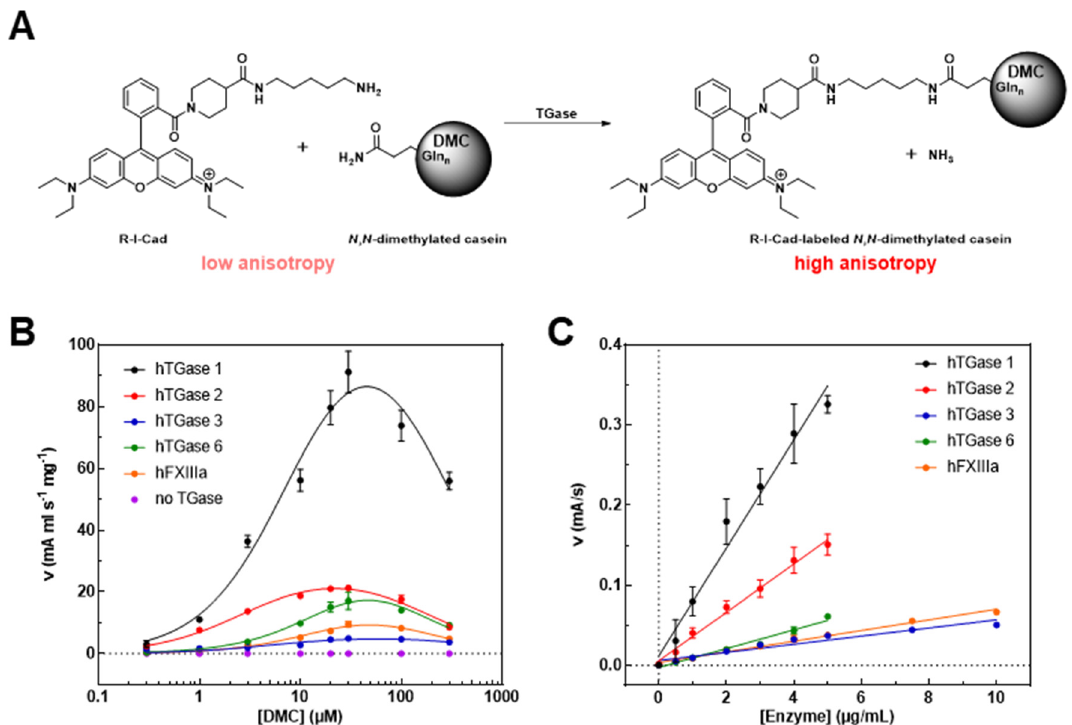
Figure 1. Incorporation of R-I-Cad into DMC by different TGases. ( A ) Principle of the FA-based TGase activity assay. ( B ) Plots of rate versus DMC concentration for the reaction of DMC with R-I-Cad (0.74 µ M) in the absence and presence of different human (h) TGases (2 µ g/mL for hTGase 1; 5 µ g/mL for hTGases 2, 3, 6 and hFXIIIa). Nonlinear regressions were conducted according to Equation (2) (substrate inhibition; Section 4.3.1). ( C ) Plots of rate versus hTGase concentration for the reaction of DMC (30 µ M) with R-I-Cad (0.74 µ M) with linear regressions. Data shown are mean values ± SEM of 2–3 separate experiments, each performed in duplicate. Conditions: pH 8.0, 30 °C, 5% DMSO, and 500 µM DTT. Data for hTGase 2 in ( B ) and ( C ) have previously been published [54]. (Adapted with permission from Wodtke et al. [54]. Copyright 2022 American Chemical